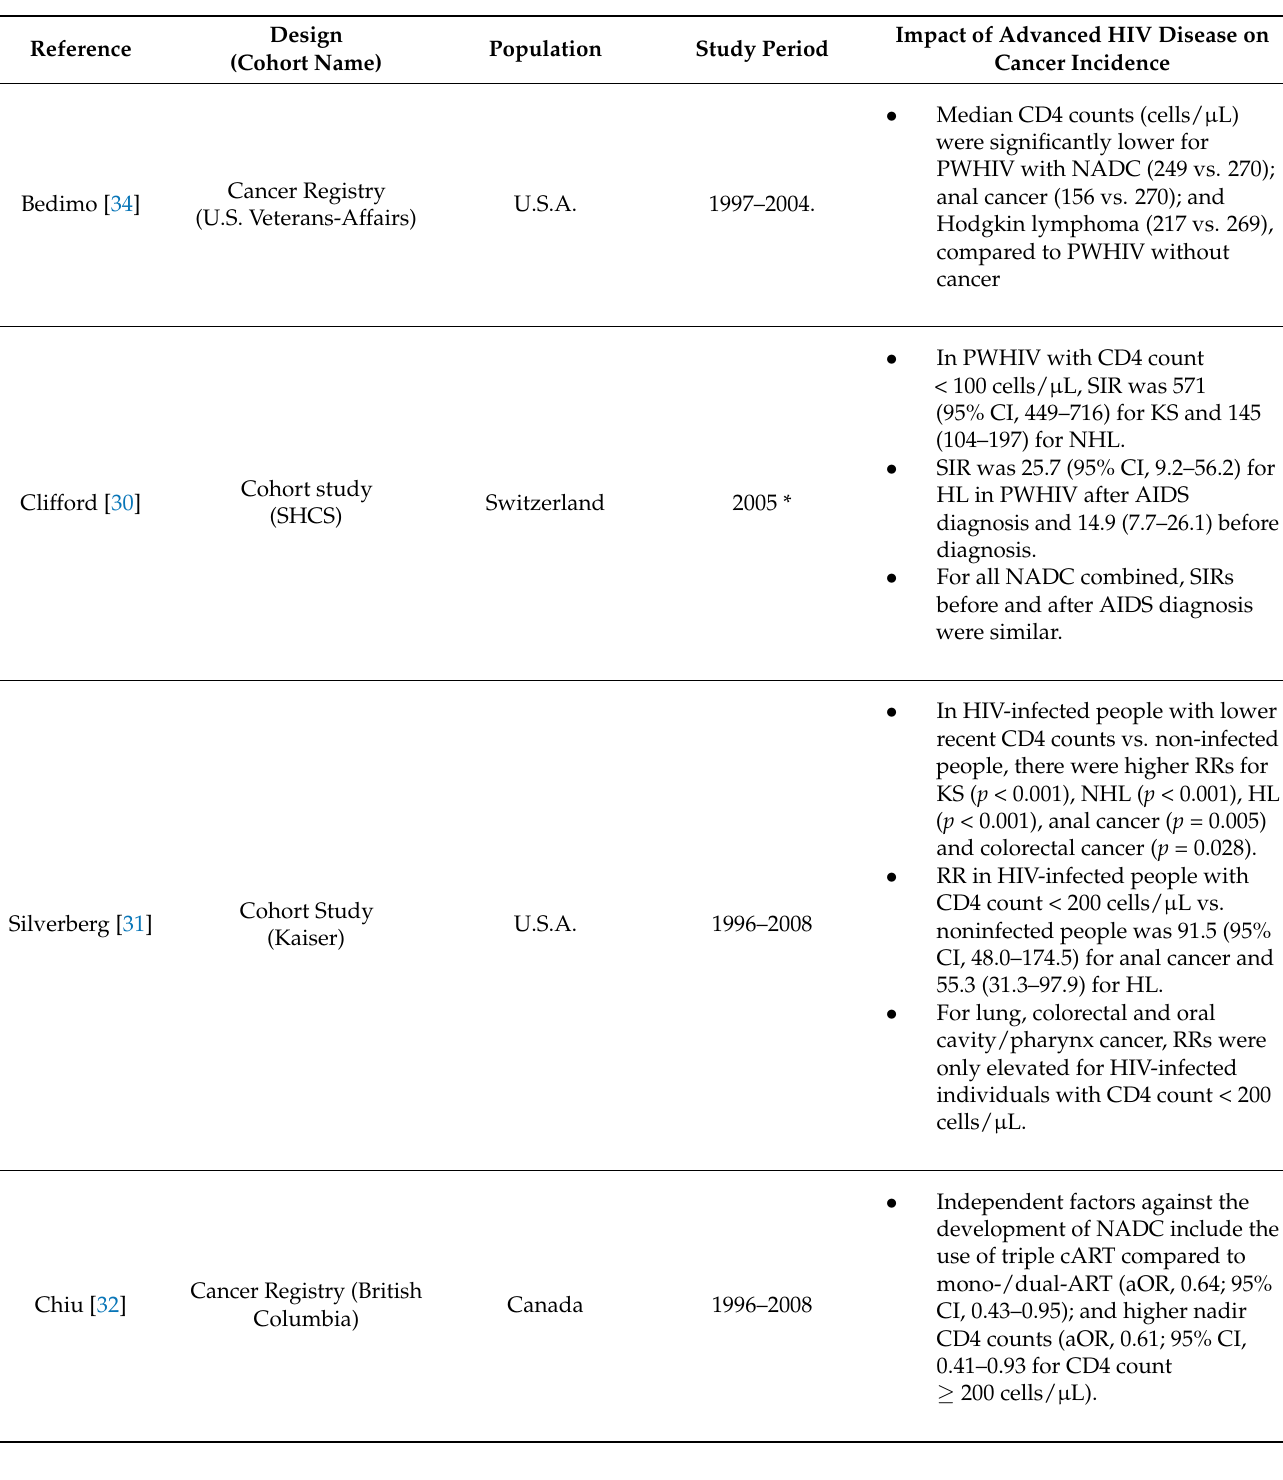
Table 2. Impact of advanced HIV disease on cancer